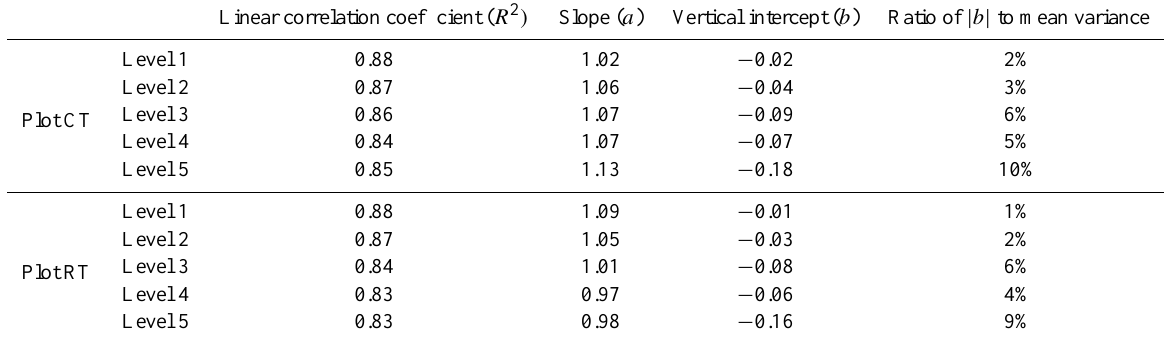
Table 8. Horizontal wind variance. Linear regression parameters between the experimental and the modelling data, α =1.20 and δ =1.36. Linear correlation coefficient ( R 2 ) Slope ( a